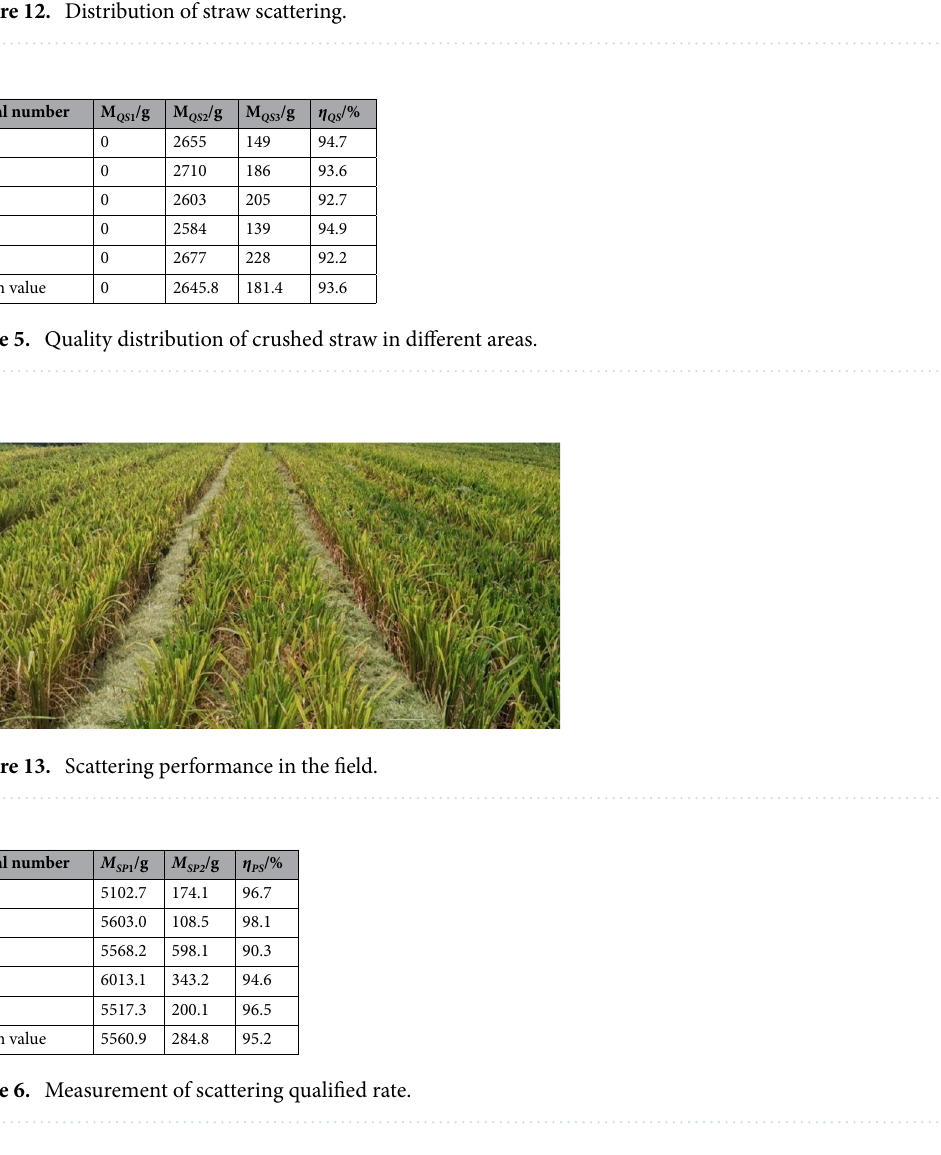
Figure 12. Distribution of straw scattering.